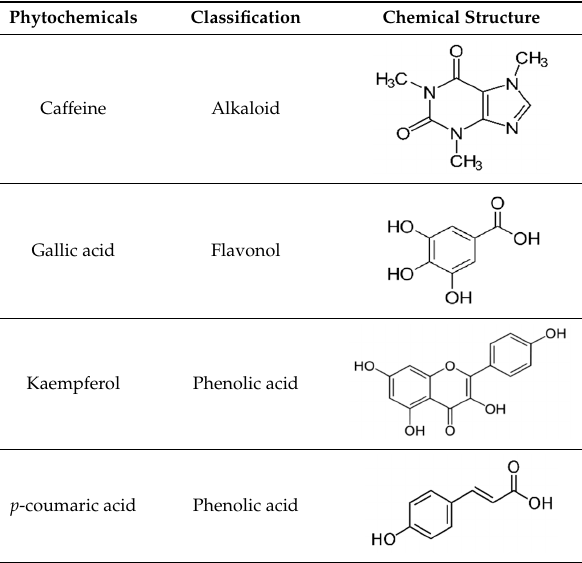
Table 1. Structures and classification of phytochemicals used for dietary supplementation.